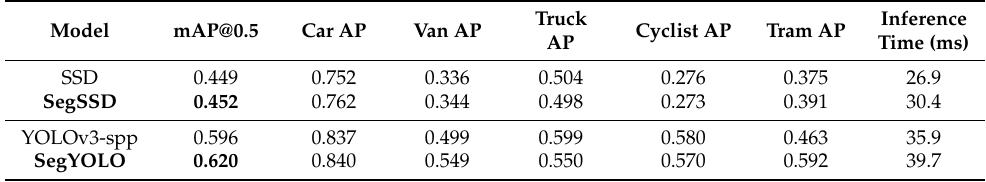
Table 2. KITTI test detection results. Inference times are test on GTX1650 GPU.